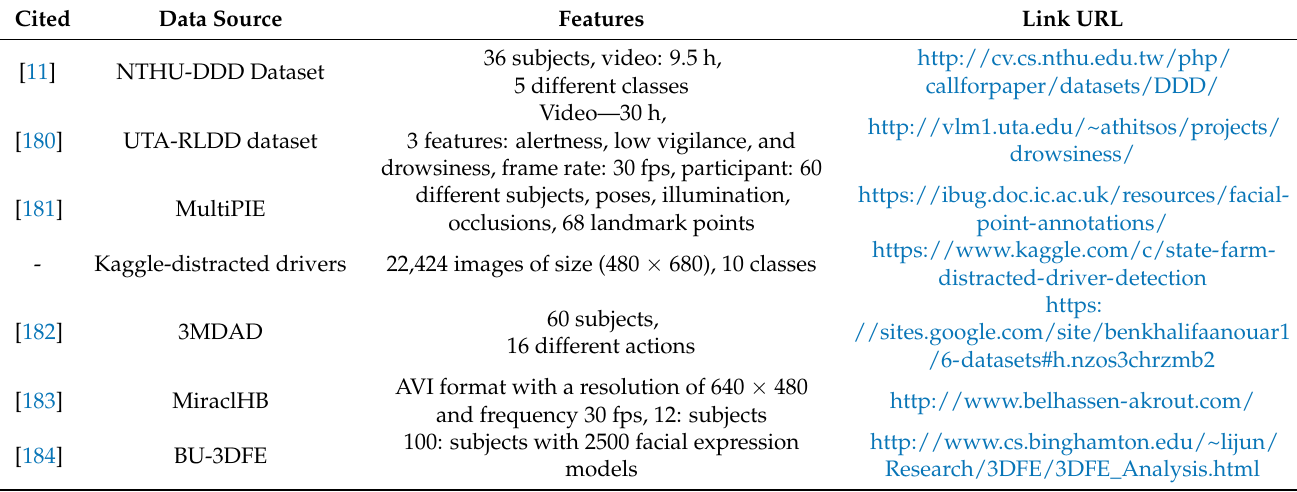
Table 4. Extraction of visual features used to train and test the network based on online state-of-the-art vision-based datasets.